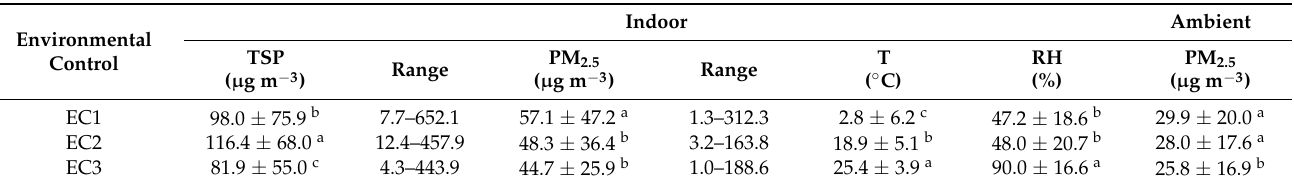
Table 2. Hourly mean ( ± SD) of TSP and PM 2.5 concentrations, indoor T, and indoor RH under three ECs of the dairy barn over a